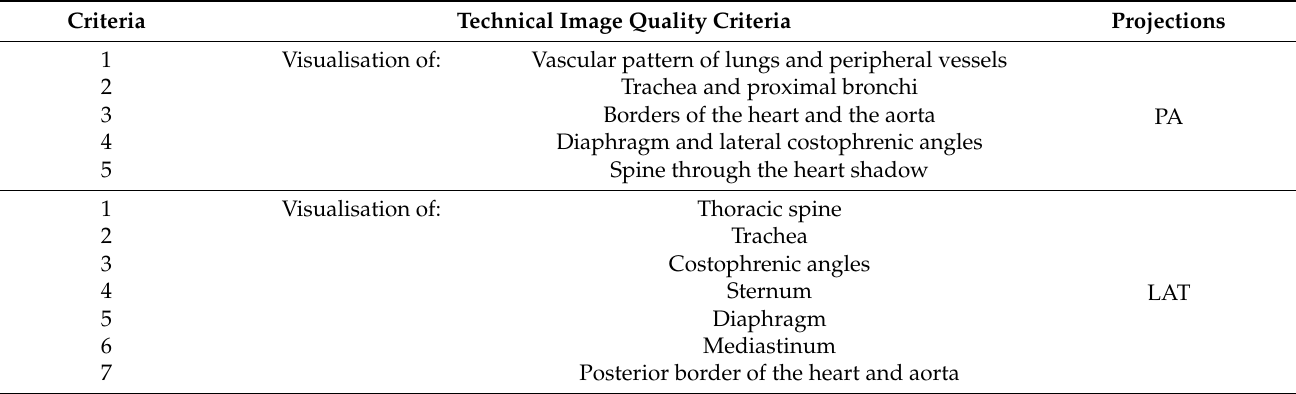
Table 4. Image quality criteria for the chest examination protocols in both PA and LAT projections.